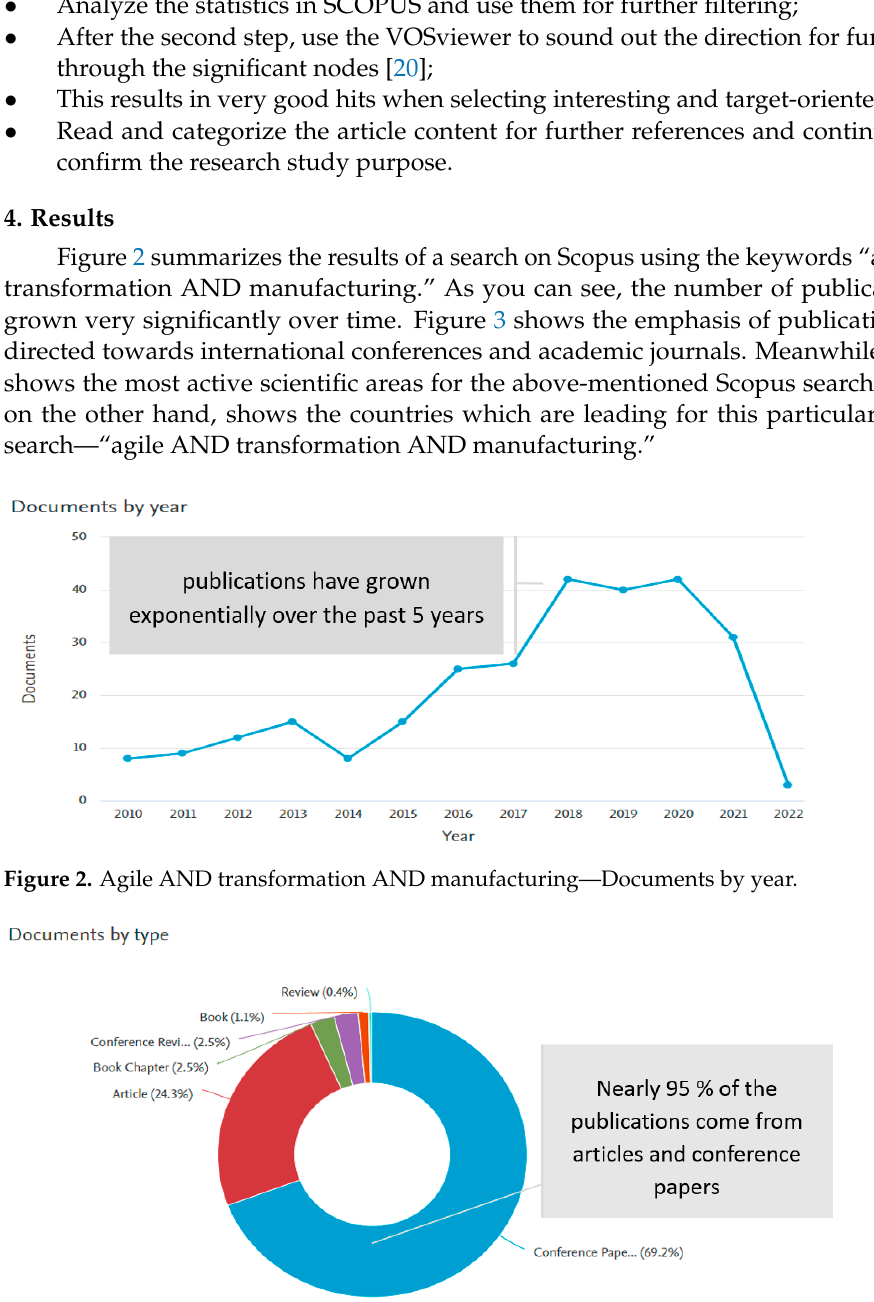
Figure 4. Agile AND transformation AND manufacturing—Documents by Subject area. Figure 5. Agile AND transformation AND manufacturing—Documents by Country. For example, if you take a search result from the SCOPUS database with the same keywords ‘Agile’ AND ‘Transformation’ AND ‘Manufacturing’ and transfer the data with